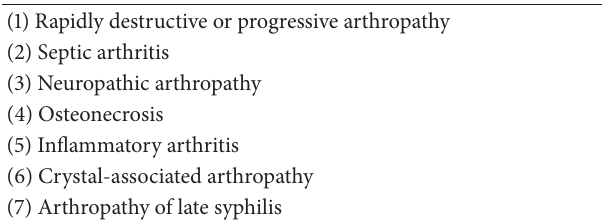
Table 2: Differential diagnosis of Milwaukee shoulder